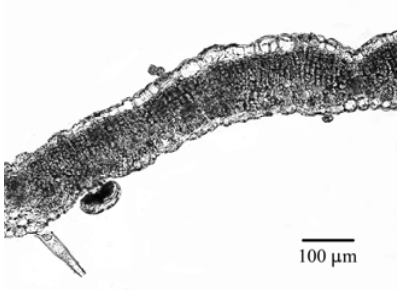
Figure 2. Leaf cross section of S. pratensis (left) and S. bertolonii